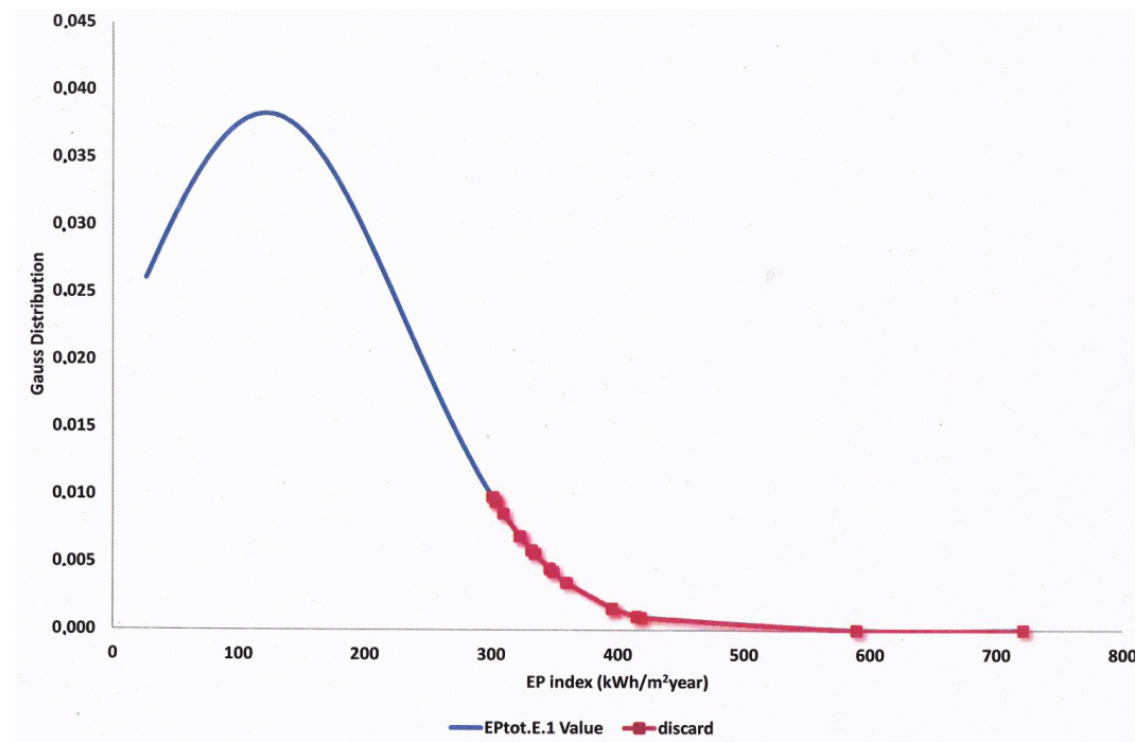
Figure 3. Gauss function of dwelling